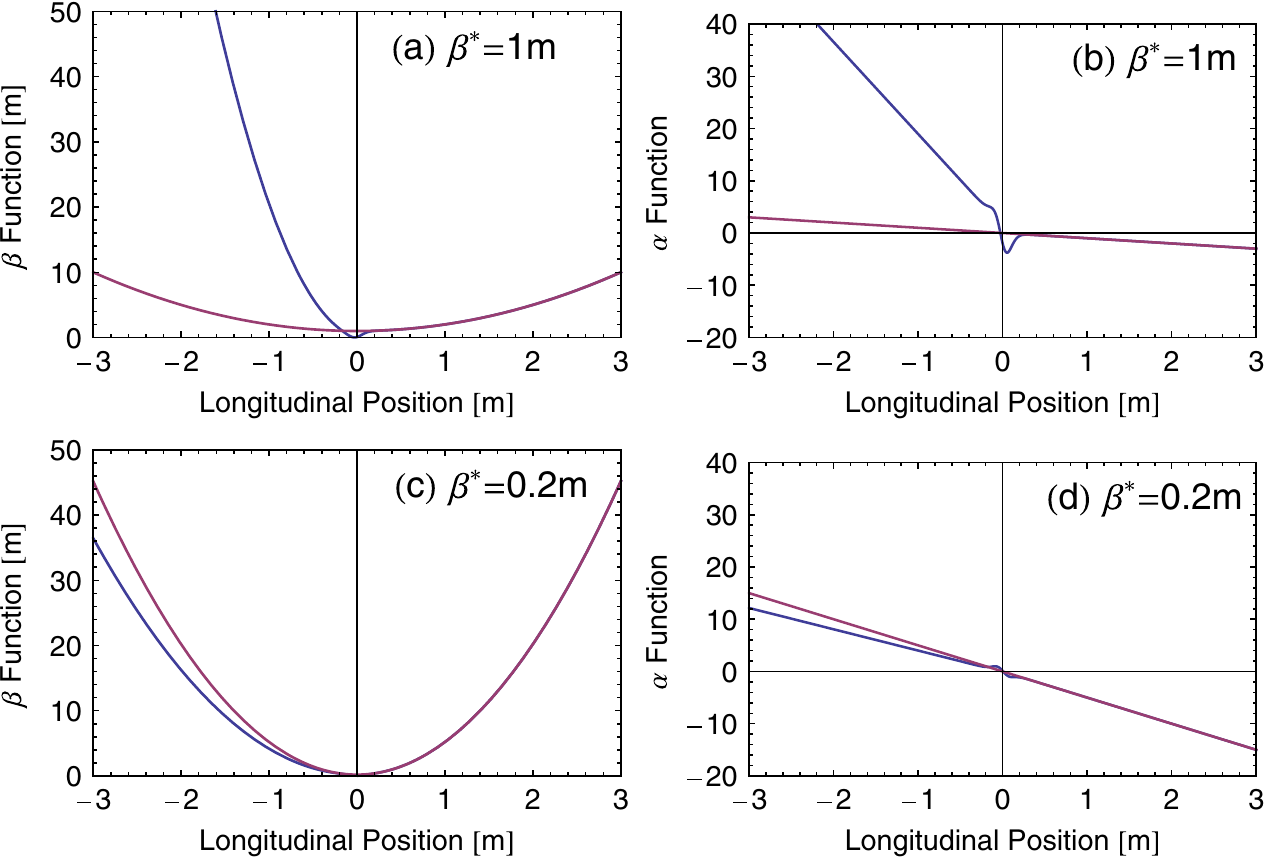
FIG. 1. (Color) The numerical solution of alpha and beta functions in IR. The solution of Eqs. (10) is the blue curve, while the red curve corresponds to the solution without beam-beam force. In (a) and (b), (cid:6) (cid:5) ¼ 1 m ; in (c) and (d) (cid:6) (cid:5) ¼ 0 : 2 m . In all graphs, s (cid:5) ¼ 0